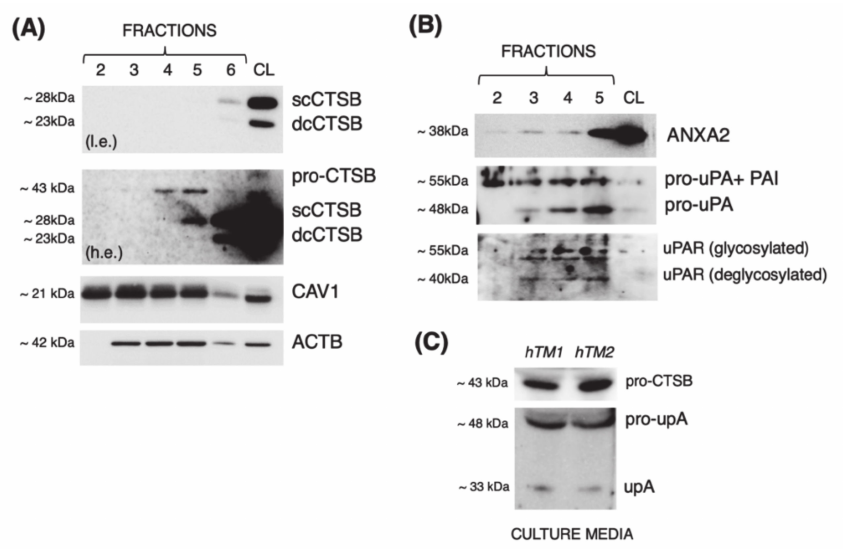
Figure 1. Localization of CTSB and members of the proteolytic cascade in the caveolae. Representative WB showing expression of ( A ) CTSB (pro-CTSB, sc-CTSB, dc-CTSB) and CAV1, or ( B ) ANXA2, pro- uPA and uPAR in caveolae-enriched fractions (2–5, 15 µ L) and cell lysates (CL) from hTM cells. l.e.: lower exposure; h.e.: higher exposure. ( C ) Representative WB showing expression of pro-CTSB, pro-uPA, and uPA in conditioned media (15 µ L) from hTM